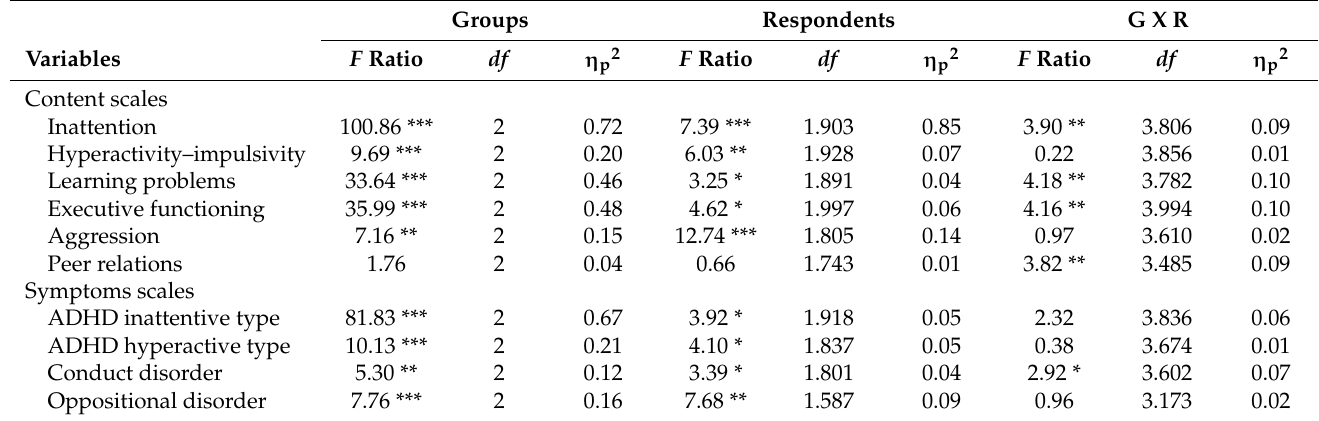
Table 4. Repeated-measures ANOVA statistics for the Conners 3 content and symptoms scales.